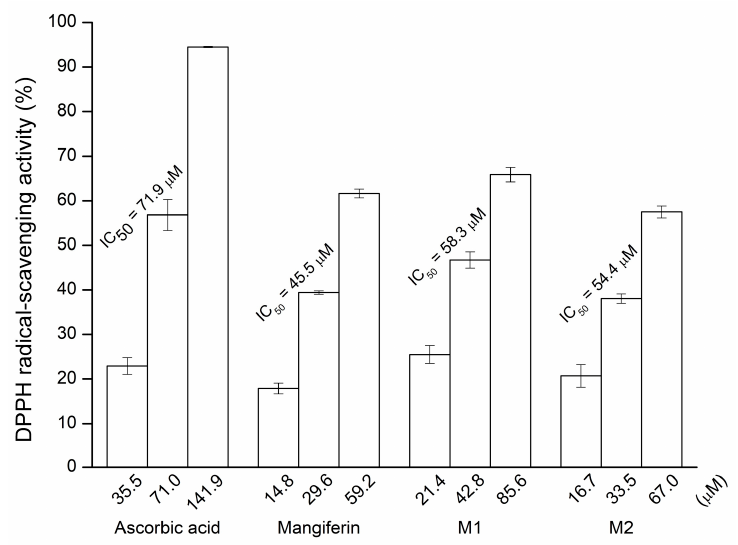
Figure 9. The 1,1-diphenyl-2-picrylhydrazyl (DPPH) free radical scavenging activity of mangiferin, mangiferin glucosides, and ascorbic acid. The DPPH scavenging activity was determined as described in Section 2. The IC 50 values represent the concentrations required for 50% DPPH free radical scavenging activity. The mean ( n = 3) is shown, and the standard deviations are represented by error bars. M1 and M2 are glucosyl- α -(1 → 6)-mangiferin and maltosyl- α -(1 → 6)-mangiferin, respectively.